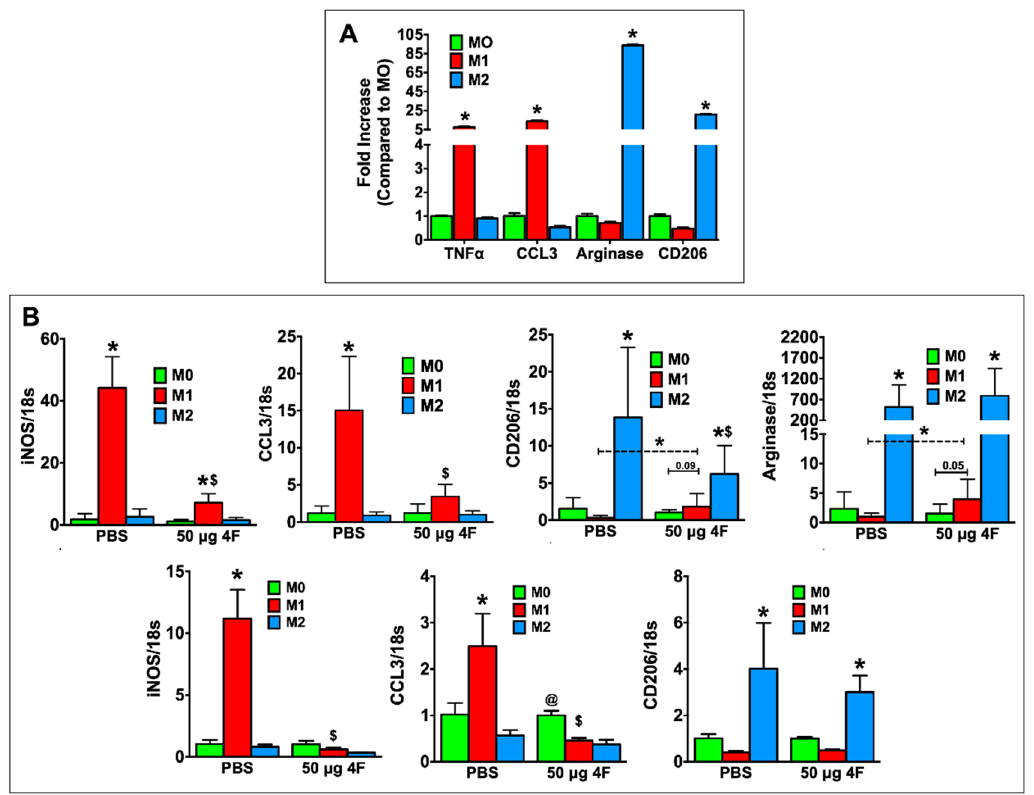
Figure 5. L-4F inhibits M1-macrophage activation and induces macrophage plasticity in vitro. ( A ) RT-PCR analysis of M1 and M2 macrophage-associated marker genes in mouse peritoneal macrophages polarized in vitro. ( B ) RT-PCR analysis of M1 and M2 macrophage-associated marker genes from polarized RAW 264.7 cells (upper panels) or polarized mouse peritoneal macrophages (lower panels) after overnight treatment with either PBS or L-4F (50 µ g / mL). Data are presented as fold changes (mean ± SD) and compared to non-polarized M0 macrophages. * p < 0.05 vs. respective M0; $ p < 0.05 vs. PBS-treated M1 group, @ p < 0.05 vs. respective M1 and M2 groups, n = 3 / group each done in triplicate for RAW 264.7 cells. Thioglycolate-elicited mouse peritoneal macrophages were isolated and